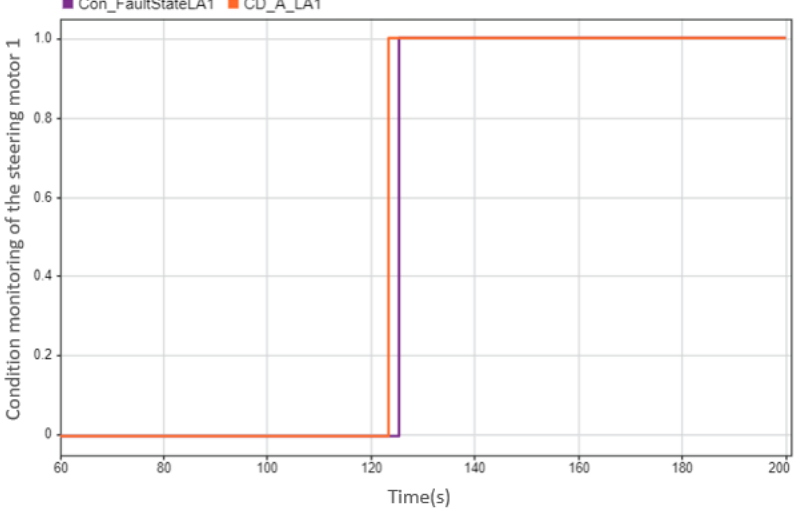
Figure 26. Result of condition monitoring of steering motor 1. Diagnostic result of condition monitoring of the steering motor 1: the case is that the steering motor 1 fails at 123.5 s, but the diagnostic result shows the failure is at 125.3 s (“CD” is an abbreviation for “condition”; “0” refers the normal state; “1” refers the faulty state; the orange line refers to the real state of the steering motor 1; the purple line refers to the diagnostic state of the steering motor 1).